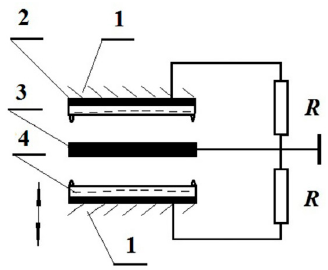
Figure 2. Two-capacitor impact generator: 1 —Housing; 2 —Electrode; 3 —Moving electrode; and 4 —Electret. Arrows show the direction of the housing vibrations.